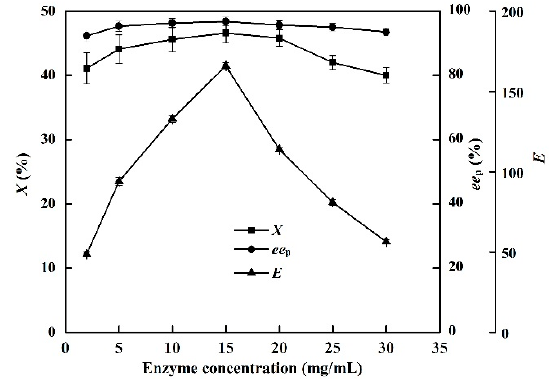
Figure 6. Effect of enzyme concentration on the conversion degree, enantiomeric excess of product and enantioselectivity of EST10 using [OmPy][BF 4 ] as a co-solvent at 75 °C for 10 h. The concentration of racemic ibuprofen ethyl ester was 2.5 mg/mL. The values are means of three independent experiments.